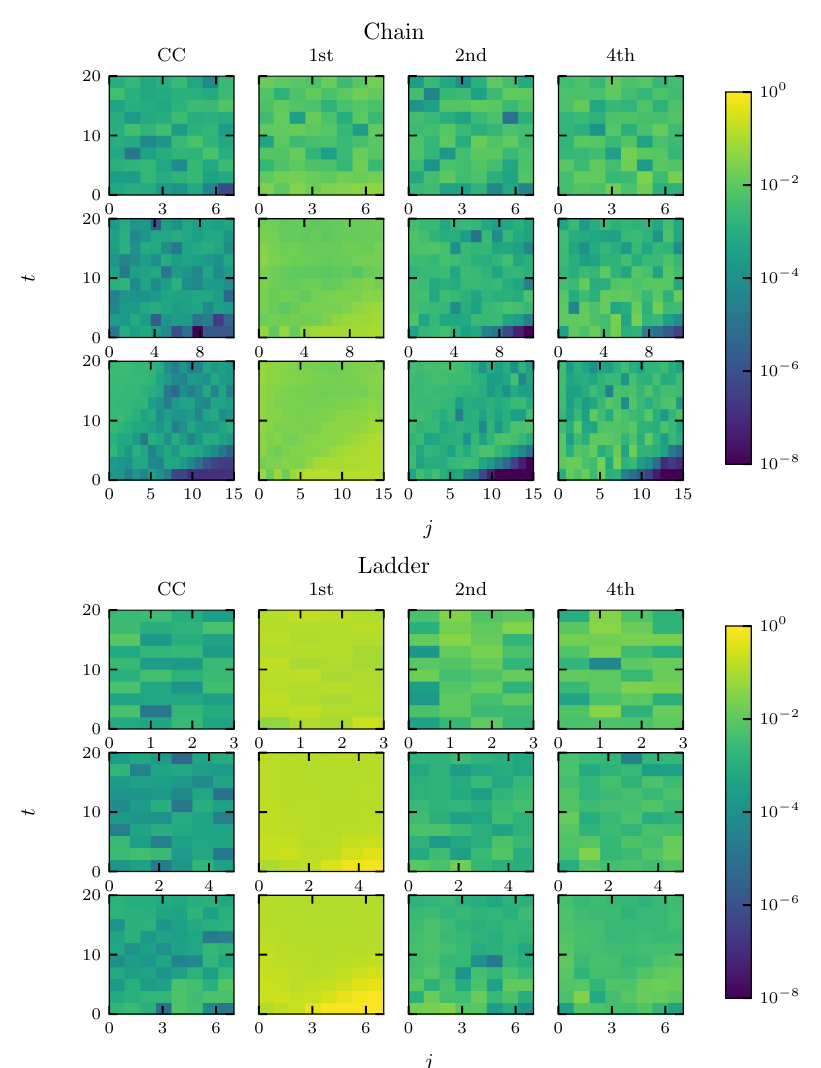
( t ) errors for the chain (top three rows) and ladder Figure 7: The absolute C i = 2, j (bottom three rows) for a compressed circuit optimized at t = 2 and stacked up to ten times, along with the errors for Trotter circuits with similar gate counts. For the chain j labels the sites and for the ladder it labels the rungs. The first and fourth row are for L = 8 with χ = 256, the second and fifth row are for L = 12 with χ = 150, and the third and sixth row are for L = 16 with χ = 100. The first column is for the compressed circuit, the second, third and fourth columns are for the first-, second- and fourth-order Trotter circuits. To have roughly equal gate counts, the used depths are M = 8,8,7,1 for the chain and M = 16,4,3,1 for the ladder, for the compressed circuit and first-, second- and fourth-order Trotter circuits,